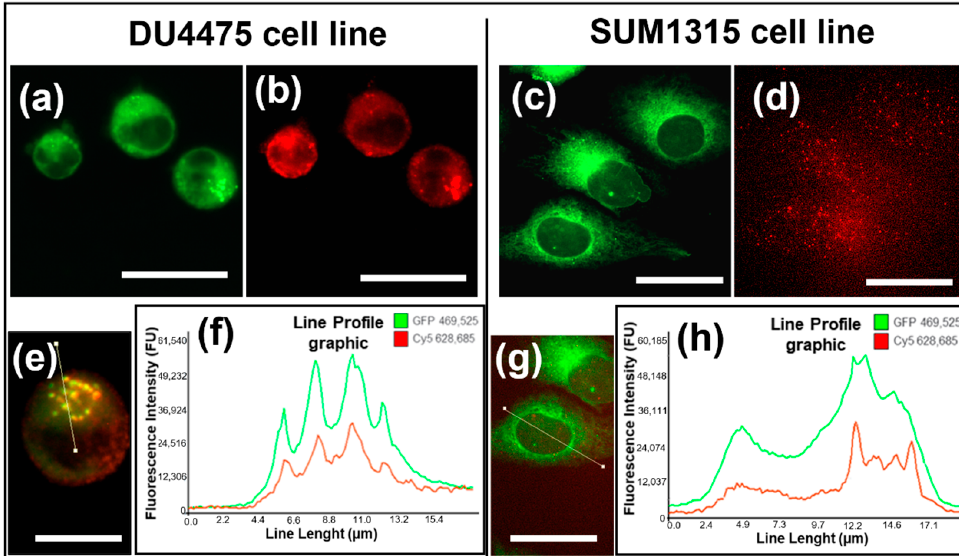
Figure 4. P-gp targeting comparison between LightSpot ® -FL-1 staining and anti-P-gp immunostaining on DU4475 and SUM1315 TNBC cell lines. Co-staining was carried out, combining LightSpot ® -FL-1 with anti-P-gp immunostaining. Pictures of LightSpot ® -FL-1 labeling (green GFP signal) are presented for DU4475 ( a ) and SUM1315 cells ( c ). Similarly, immunostaining pictures (red Cy5 signal) are presented for DU4475 ( b ) and SUM1315 cells ( d ). Merged pictures are presented for DU4475 ( e ) and SUM1315 ( g ) cells. A line profile was drawn on merged pictures, superimposing both LightSpot ® -FL-1 and anti-Pgp immunostaining signals. The fluorescence intensity spectra across the line profile are shown with the line profile graphic on DU4475 cells ( f ) and SUM135 cells ( h ). All pictures were acquired with the Cytation™3 MV (BioTek ® , M = 4 X, scale bar = 25 µm).